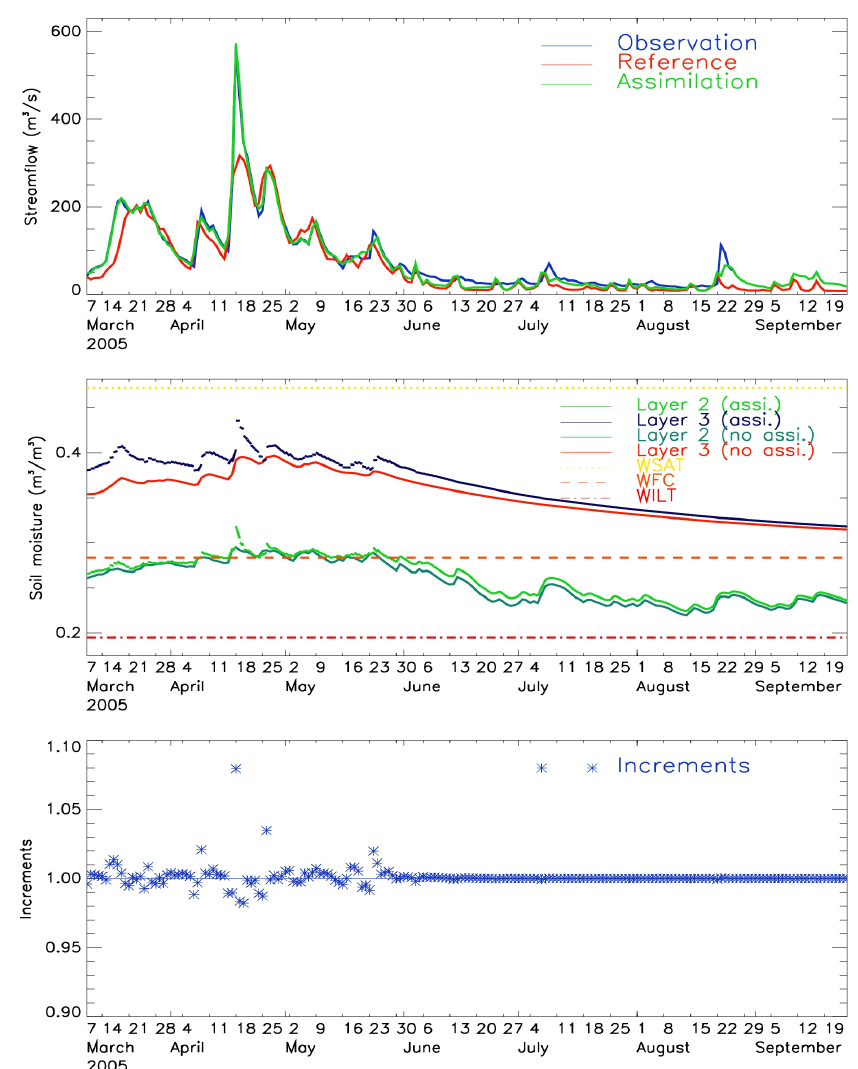
Fig. 6. Results of the assimilation process for the Doubs river at Besanc¸on for the IS 2 experiment (10 March 2005–25 September 2005) (a) Streamflows (m 3 s − 1 ). Observations are in solid blue line, the initial SIM run is in red, and the assimilated streamflows are in green. (b) Soil moisture (m 3 / m 3 ) for the basin irrigating this gauge station. Assimilated ISBA layer 2 soil moisture: light green. Original ISBA layer 2 soil moisture: dark green. Assimilated ISBA layer 3 soil moisture: blue. Original ISBA layer 3 soil moisture: red. Soil water features for this sub-basin are in dashed lines ( w sat , w fc and w wilt ). (c) : Daily increments applied by the BLUE to soil moisture. A value of 1 . 05 means that 5% of the soil moisture is added by the BLUE for the given assimilation.